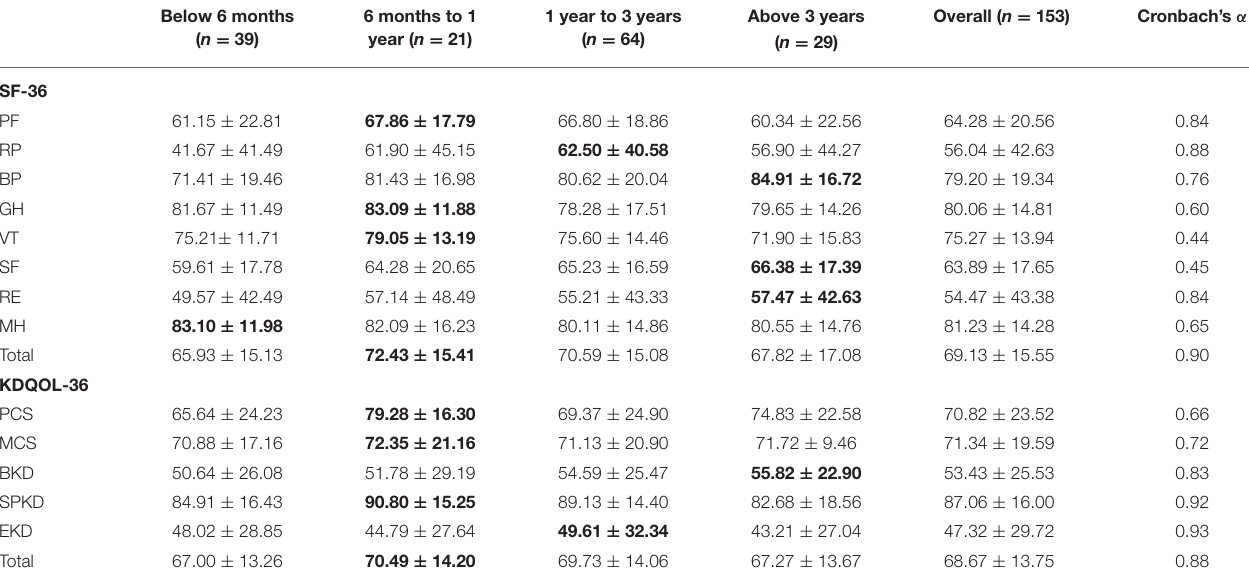
TABLE 2 | Component scores of the Short Form 36 (SF-36) and Kidney Disease Quality of Life 36 (KDQOL-36) by post-kidney transplant stages and Cronbach’s alpha values of the